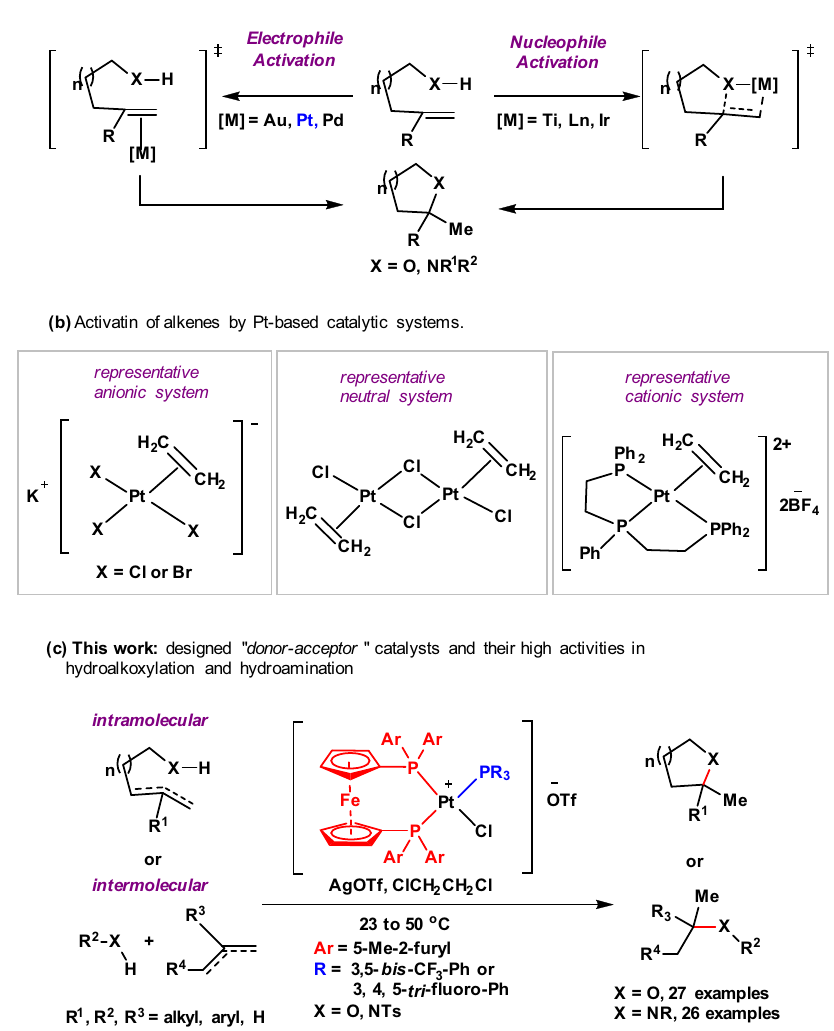
Fig. 1 Pt-catalyzed hydroalkoxylation and hydroamination of unactivated alkenes. a Activation modes for metal-catalyzed hydroalkoxylation and hydroamination. b Activation of alkenes by Pt-based catalytic systems. c This work: designed “ donor – acceptor ” catalysts and their high activities in hydroalkoxylation and